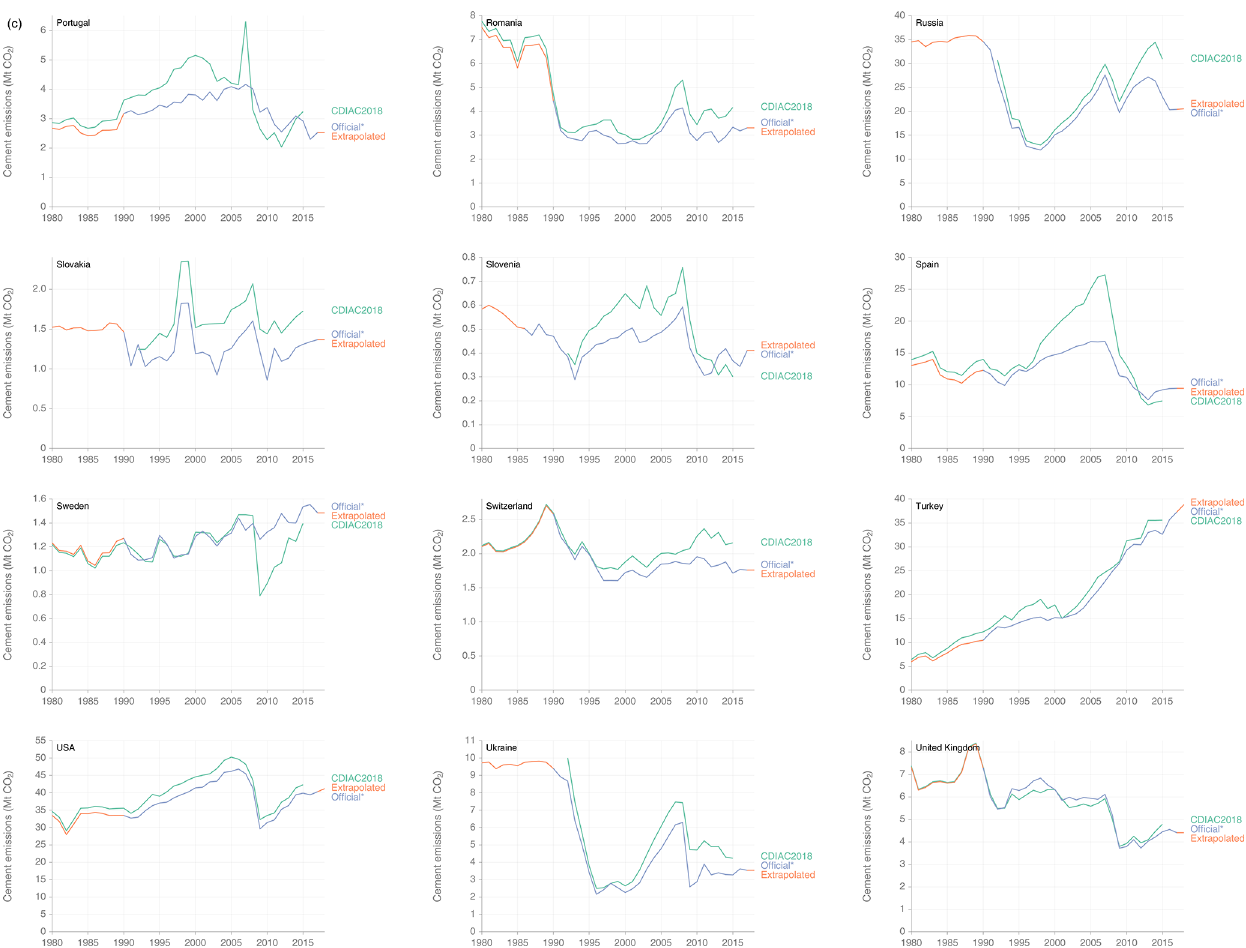
Figure C1. Revised cement emissions for Annex-I parties to the UNFCCC.